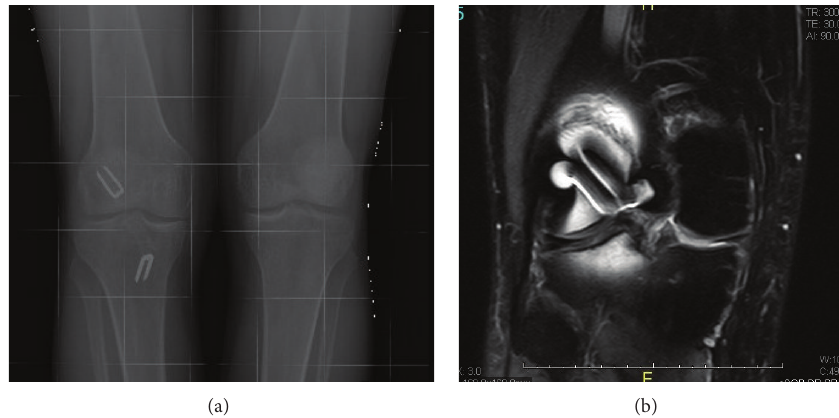
Figure 1: Imaging of the knee showing the presence of intra-articular metal staple and a medial meniscus tear ((a), (b)).